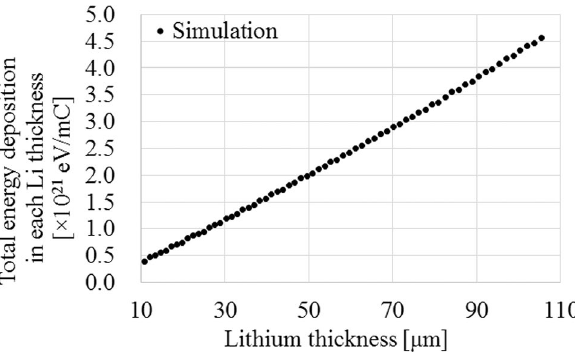
Figure 6. Total energy deposition as a function of Li thickness on the Li